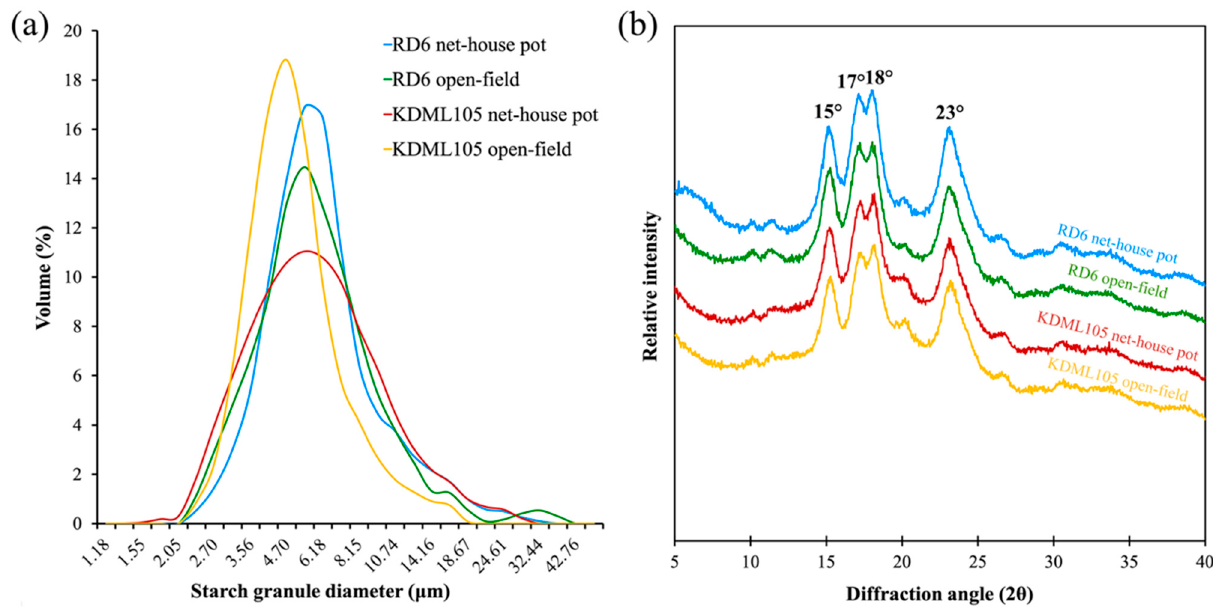
Figure 3. Characterization of starch from the grain of the two elite Thai rice cultivars grown in the net-house pot and open-field production systems. ( a ) granule size distribution; ( b ) X-ray diffraction patterns of starch granules.